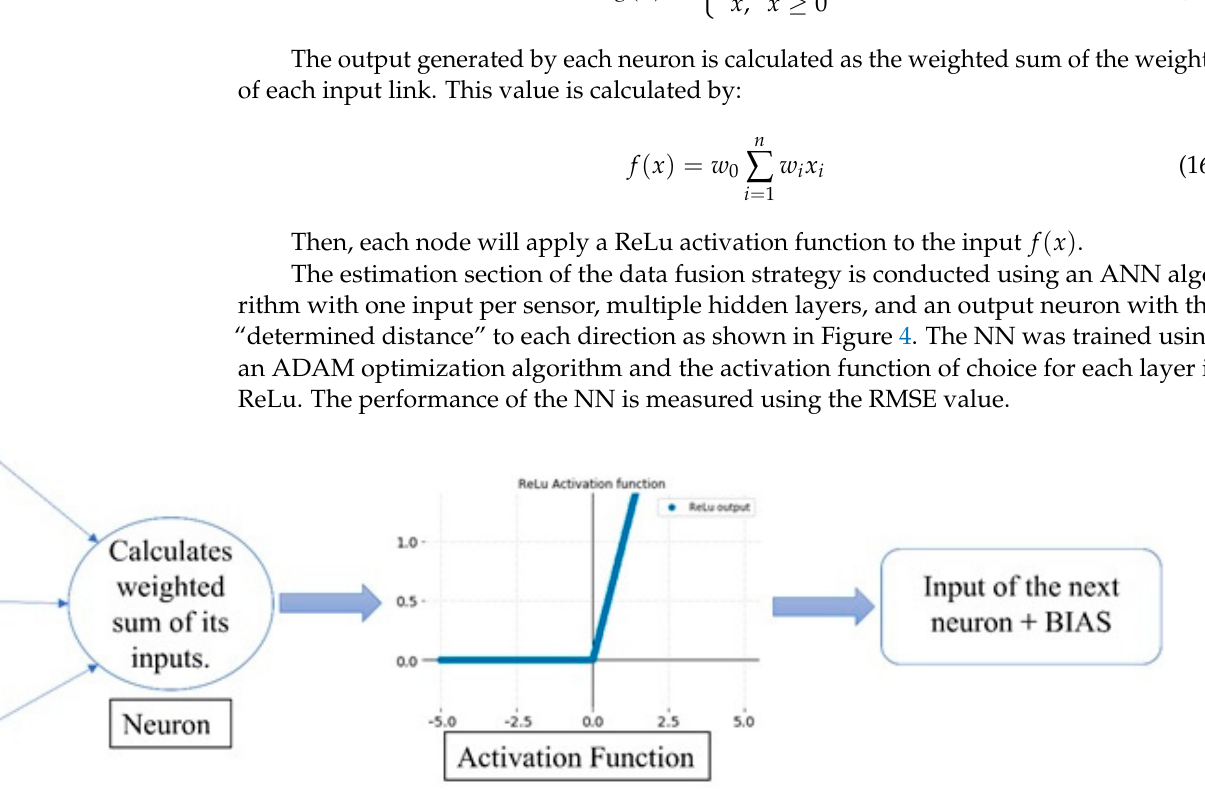
Figure 4. Working principle of the DFFNN at a neuron